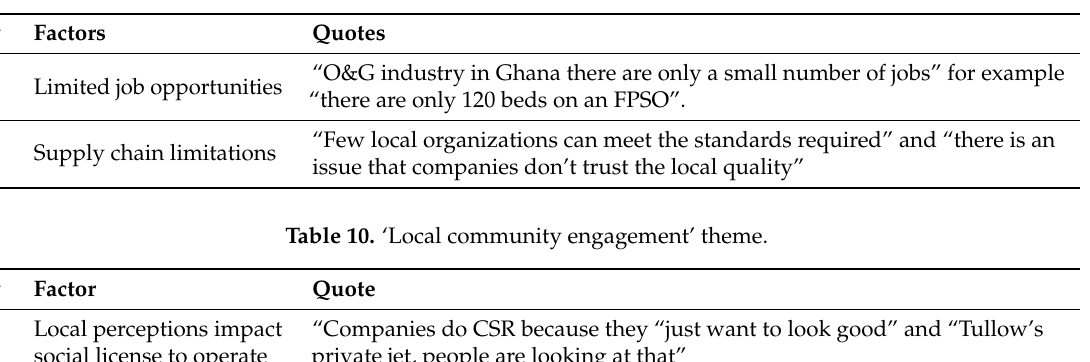
Table 9. ‘Oil and gas job & supply chain opportunities’ theme.